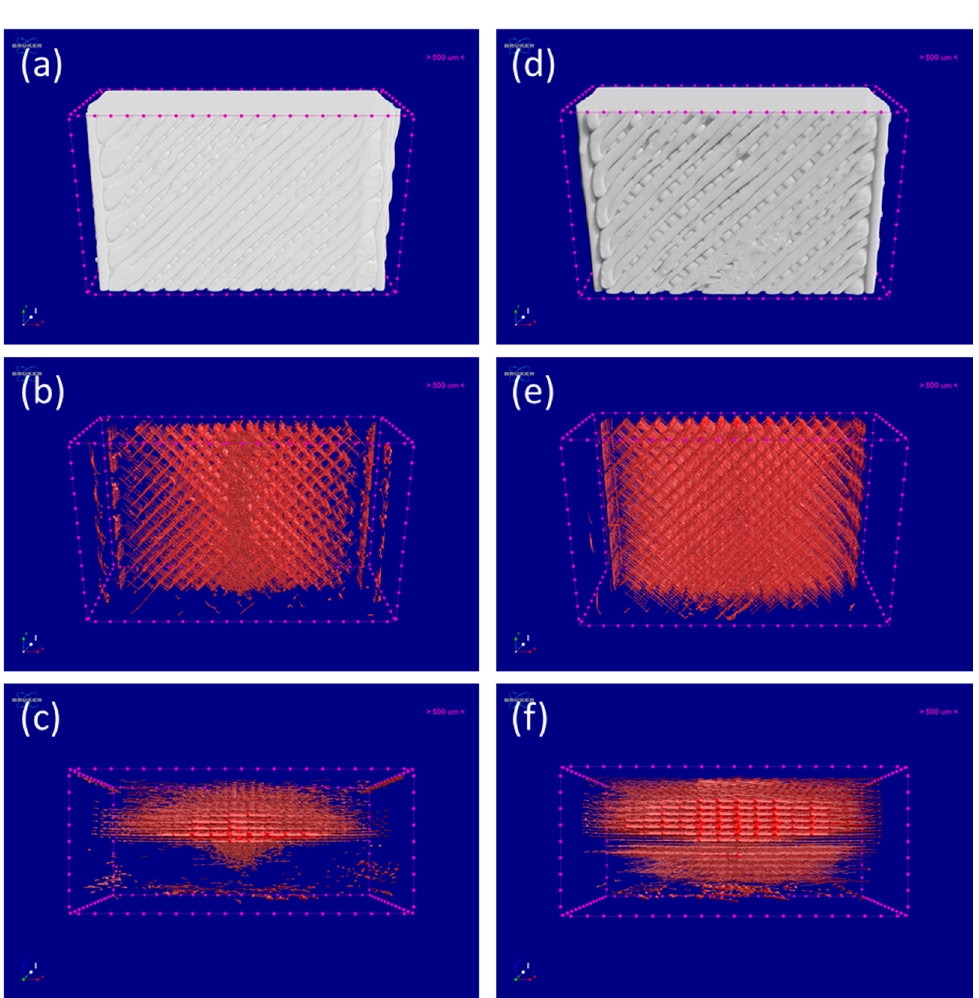
Figure 6. X-ray computed tomography (XCT) scanning of 3D printed PLA and PLA/CLRS-1 composites. Left ( a – c ): PLA; Right ( d – f ): PLA/10% CLRS-1. ( a , d ) present the schematic diagram of XCT scanning sample. ( b , c , e , f ) illustrate the 3D image from different angles. The Z-axis is the printing orientation, Y-axis is building orientation, and the deep orange parts are pores.